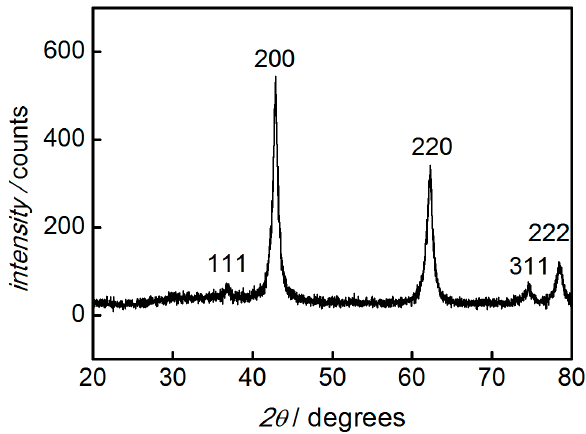
Figure 7. Powder XRD pattern of MgO prepared by using PDMAAm polymer as the porogenic structure matrix.